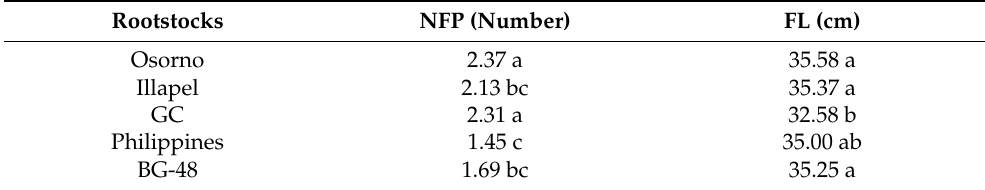
Table 2. Effect of five L. siceraria rootstocks on the number of fruits per plant (NFP) and fruit length (FL) of grafted watermelon cv. Santa Amelia F1 grown under field